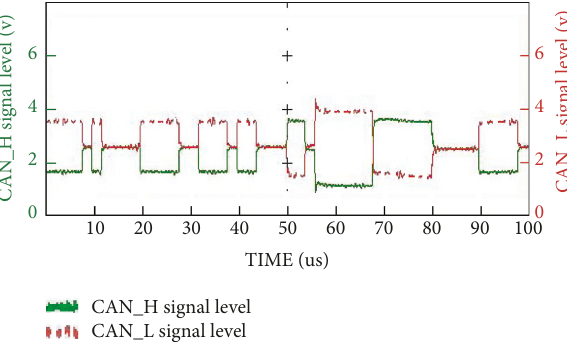
Figure 9: Signal waveform under the conditions of CAN_H and L being